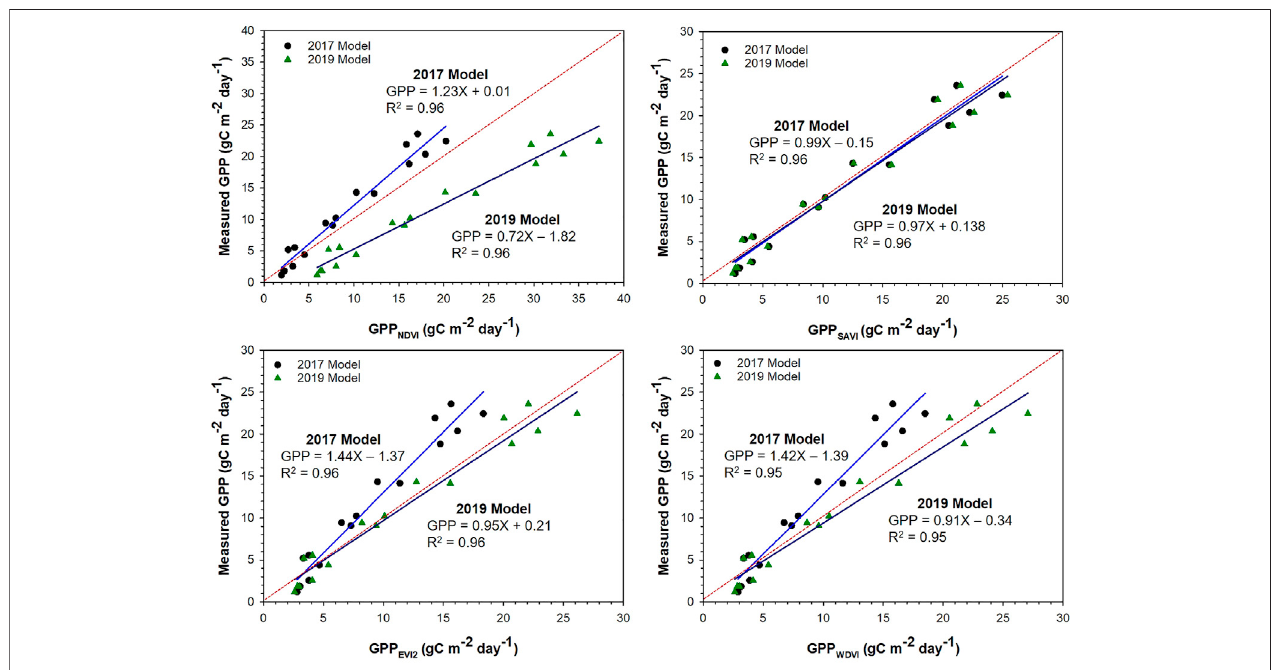
FIGURE 7 | Measured 2018 gross primary production (GPP) against predicted GPP using the 2017 and 2019 GPP models. Straight lines are regression lines and the dotted red line is the 1:1 line.